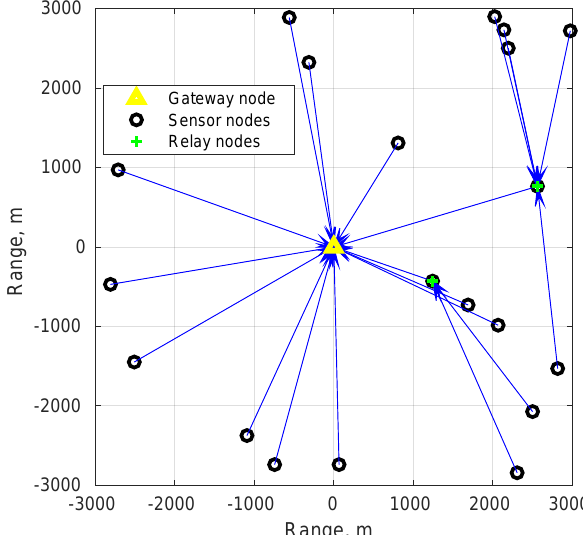
Figure 10. Example of the dual-hop routing strategy applied to a network of 20 sensor nodes at approx. 500 m depth with 3 km communication range. The sensor nodes outside the gateway node’s coverage send their data via other sensor nodes. The gateway node is responsible for gathering data packets from all directly connected sensor nodes, and the relay nodes are responsible for gathering data within their respective network branches